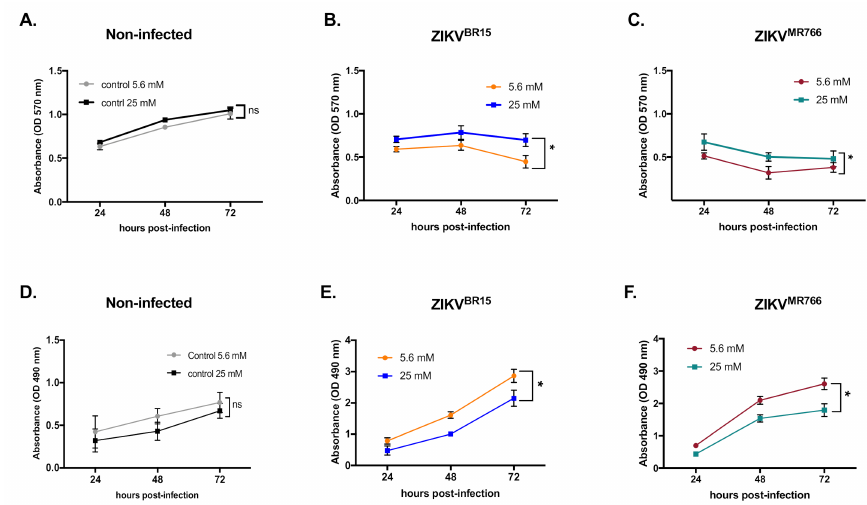
Figure 2. ZIKV-mediated cytopathic effects under high-glucose condition. The metabolic activity of non-infected HK-2 cells ( A ) or infected with ZIKV BR15 ( B ) and ZIKV MR766 ( C ) at MOI of 1 in low- and high-glucose conditions was determined at different time-points of infection using 3-[4,5-dimethylthiazol- 2-yl]-2,5-diphenyltetrazolium bromide (MTT) assay. Analysis of Lactate Dehydrogenase (LDH) release was performed to evaluate the membrane integrity of uninfected ( D ), ZIKV BR15 ( E ), and ZIKV MR766 ( F ) -infected HK-2 cells. Data were obtained by measuring the absorbance at 570 nm and 490 nm for MTT and LDH assays respectively, with a background subtraction of the absorbance at 690 nm. Results are shown as means ± SEM of three independent experiments. Two-way ANOVA test demonstrates that differences are nonsignificant (ns) or statistically significant (* p <